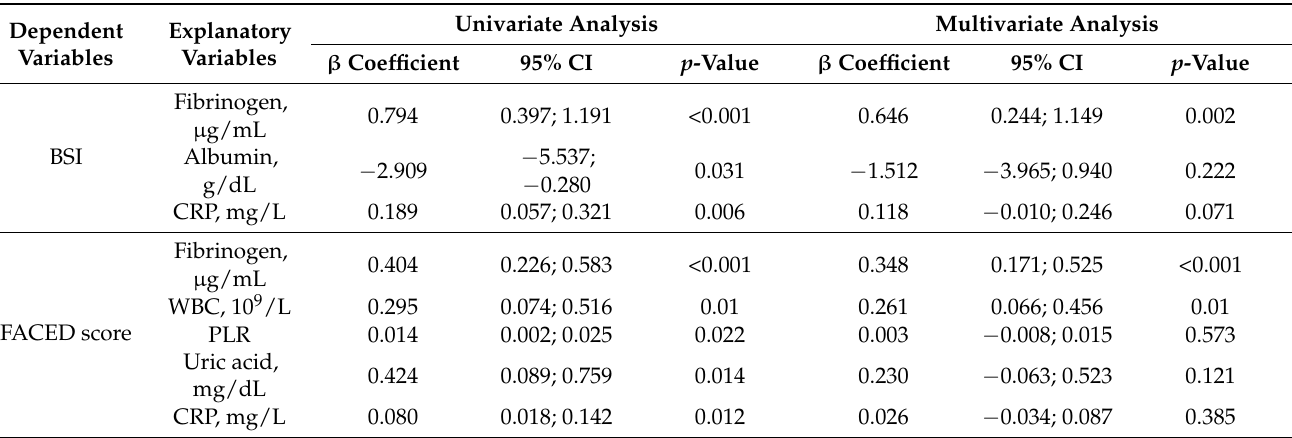
Table 2. Univariate and multivariate linear regression analysis of laboratory variables associated with BSI and FACED